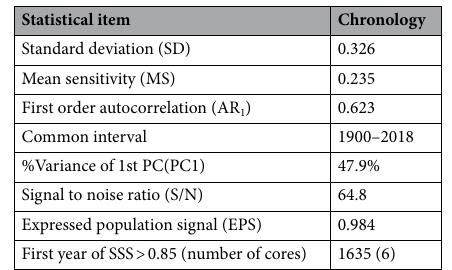
Table 1. Statistical characteristics of GS chronology.